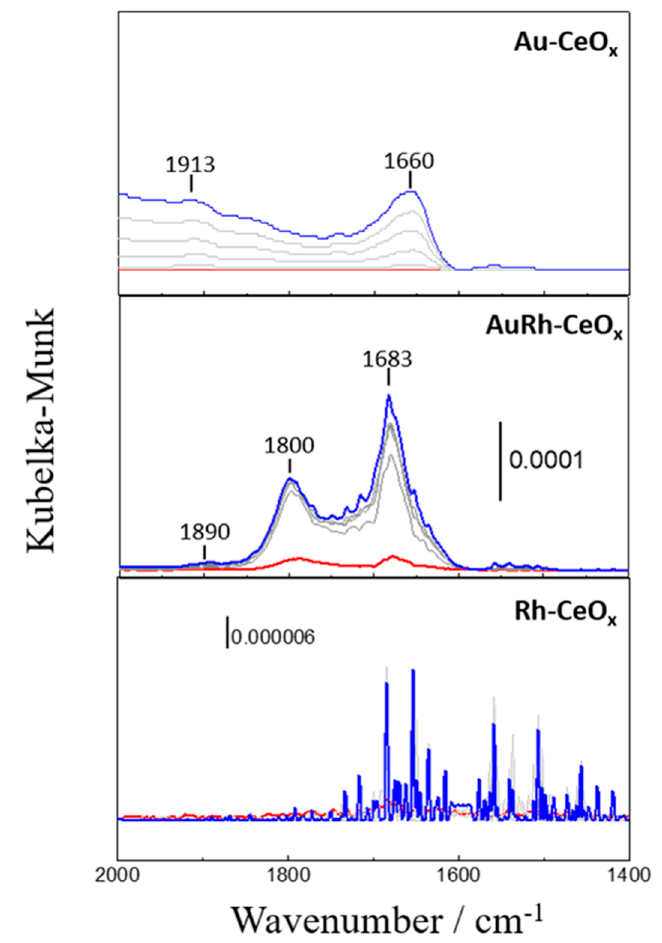
Figure 12. In situ DRIFTS spectra recorded during NO adsorption on the Au–CeO x /Al 2 O 3 , AuRh– CeO x /Al 2 O 3 , and Rh–CeO x /Al 2 O 3 catalysts at 30 °C for 5 min (from the red line to the blue line at an interval of 1 min). Gas mixture: 2000 ppm NO and He balance; total flow rate: 100